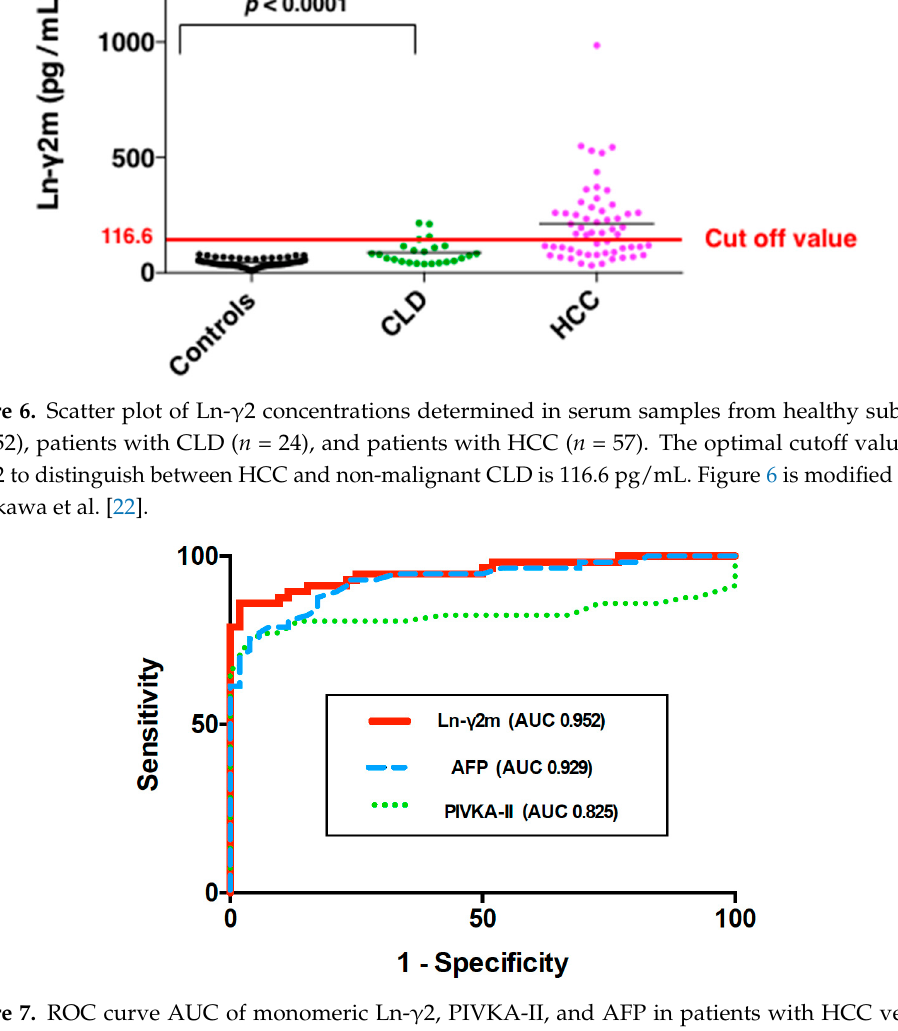
Figure 7. ROC curve AUC of monomeric Ln- γ 2, PIVKA-II, and AFP in patients with HCC versus healthy volunteers. Figure 7 is modified from Kiyokawa et al. [22].